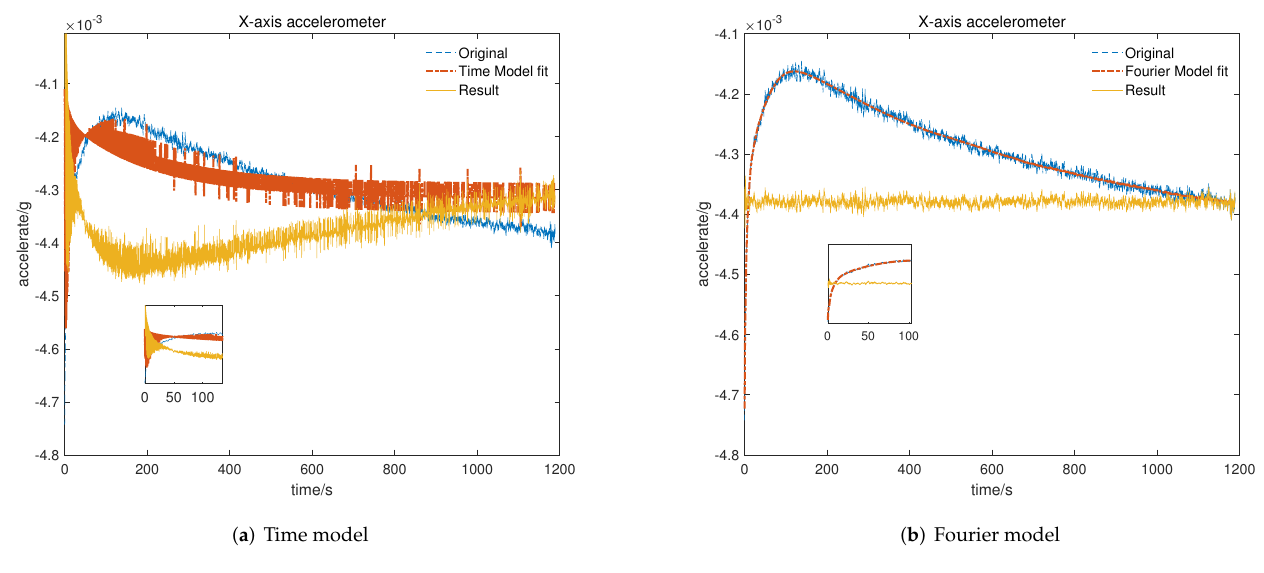
Figure 7. Result of temperature compensation for X -axis accelerometer: ( a ) compensation with time-related model; ( b ) compensation with Fourier-related model.